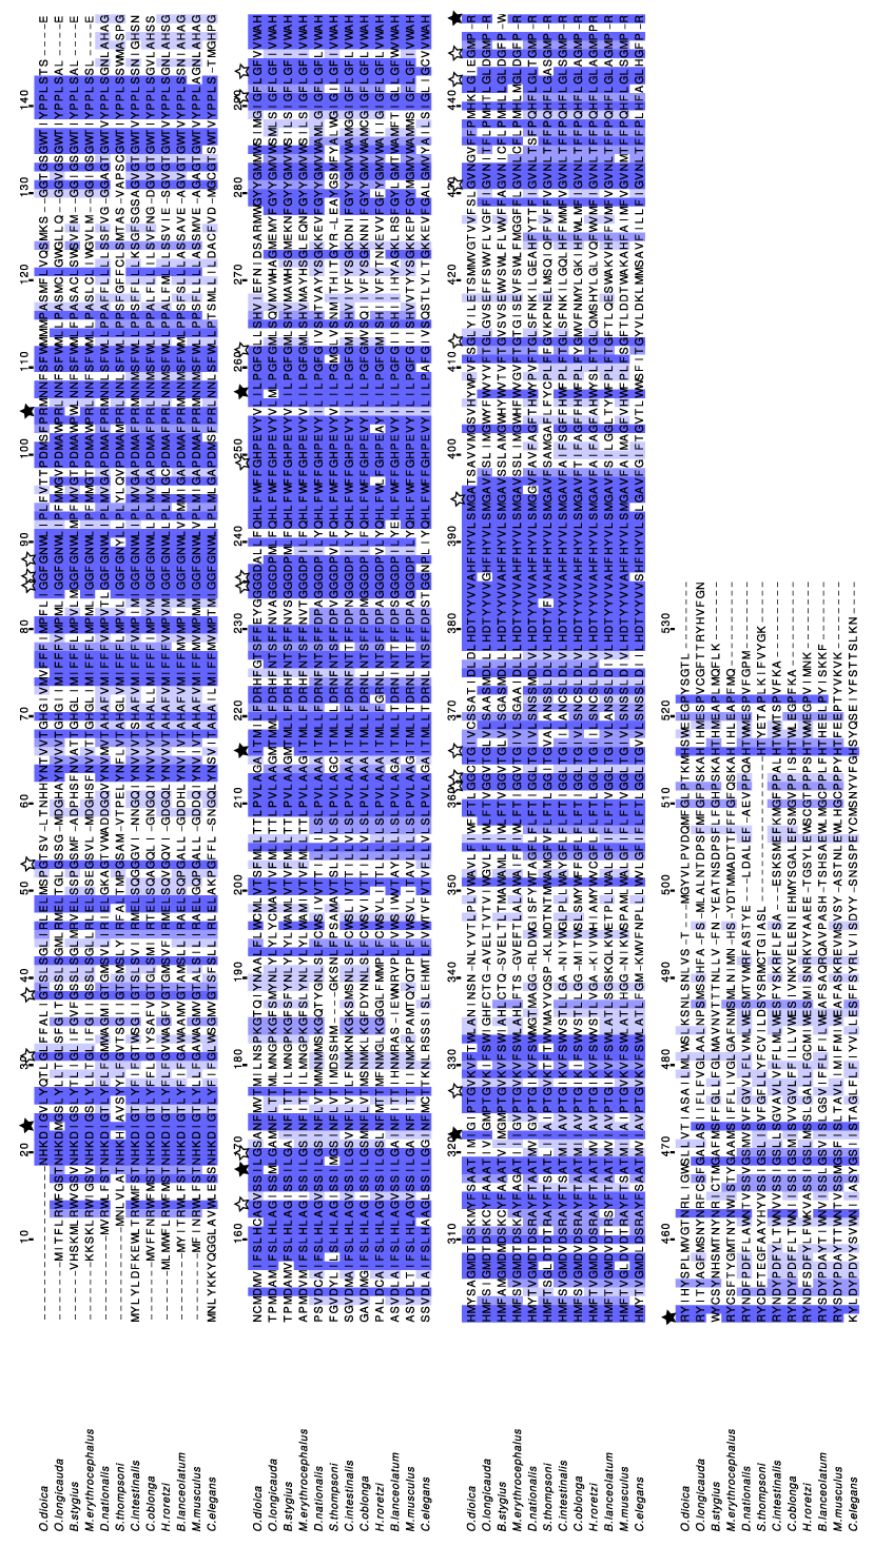
Figure 2. Sequence alignment of Cox1 proteins. White stars indicate conserved cysteines when at least one tunicate uses an AGR codon. Black stars indicate positions suggesting a different genetic